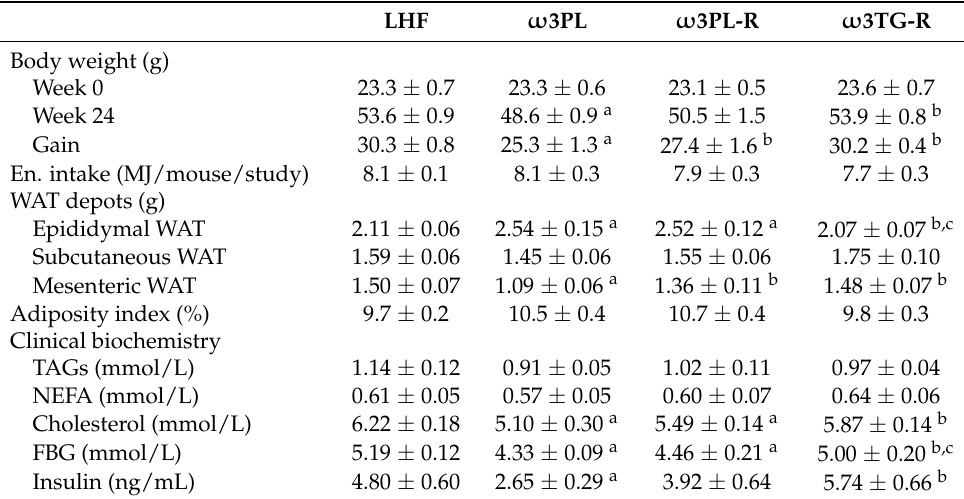
Table 1. Energy balance, adiposity, and biochemical parameters in mice fed high-fat diets supplemented or not with omega-3 PUFA concentrates.